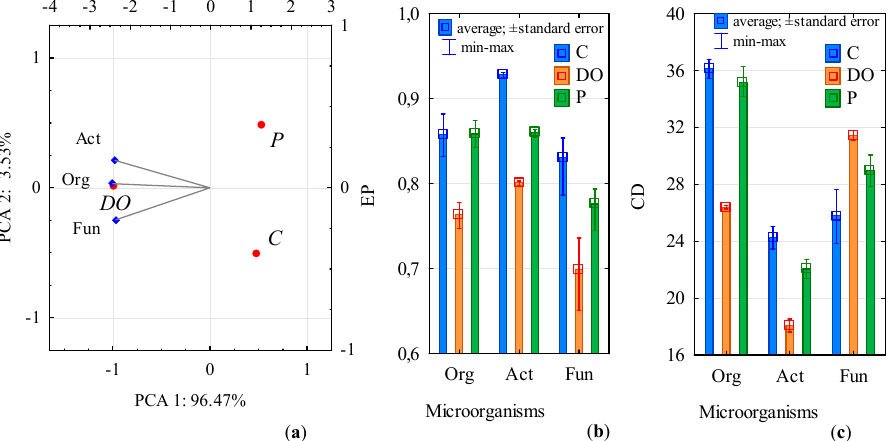
Figure 1. Microbiological properties of uncontaminated soil (C), soil contaminated with diesel oil (DO) and unleaded petroleum (P); ( a ) count of soil microorganism presented by the Principal Component Analysis (PCA) method; ( b ) physiological diversity index of microorganisms (EP); ( c ) colony development index (CD). Homogeneous groups denoted with letters (a, b, c) were calculated separately for each of microorganism. Org—organotrophic bacteria, Act—Actinobacteria, Fun— fungi.